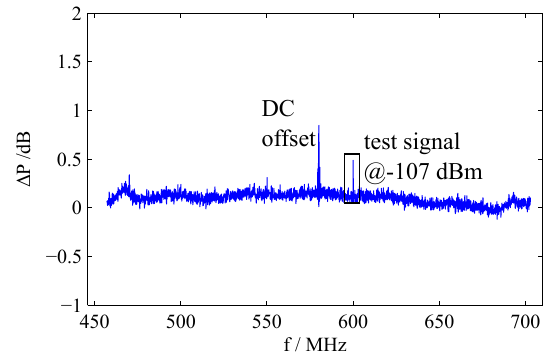
Figure 20. Sensitivity test on a sinusoidal signal with input power -107 dBm and f = 600 MHz. N